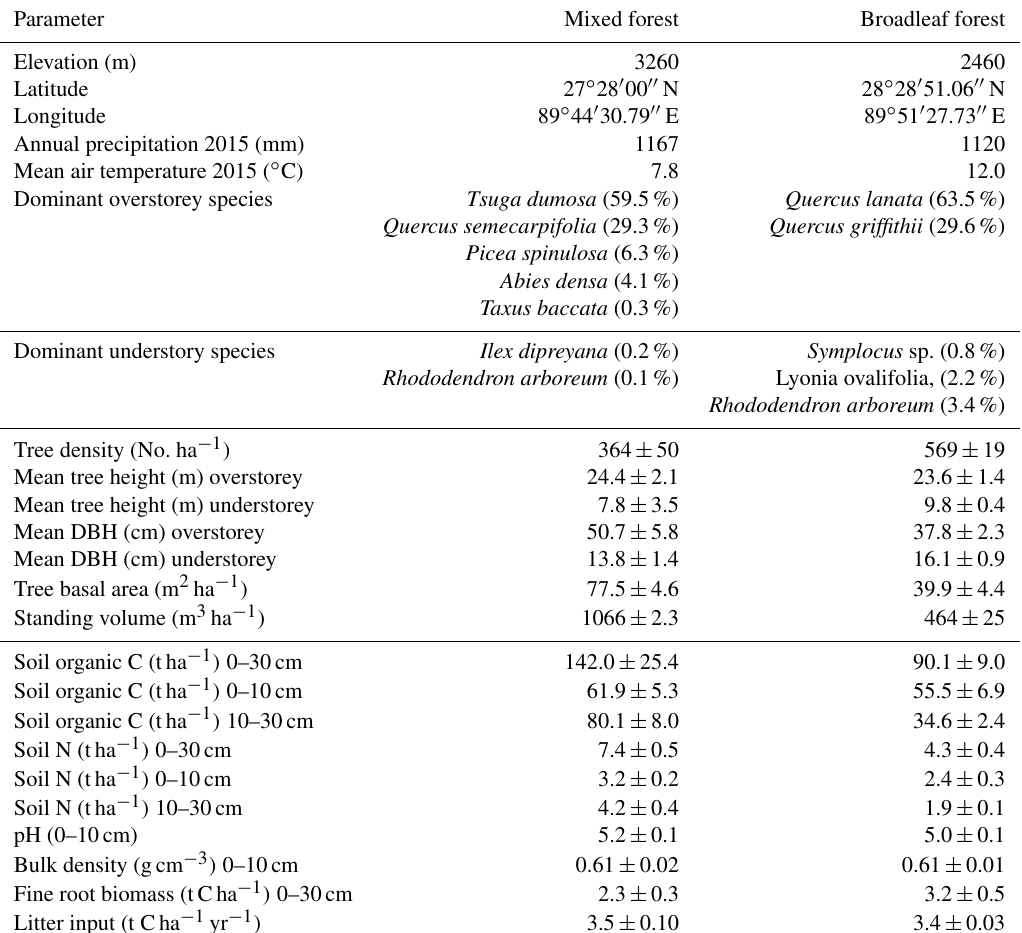
Table 1. Site characteristics of the two studied forests. Parameter Mixed